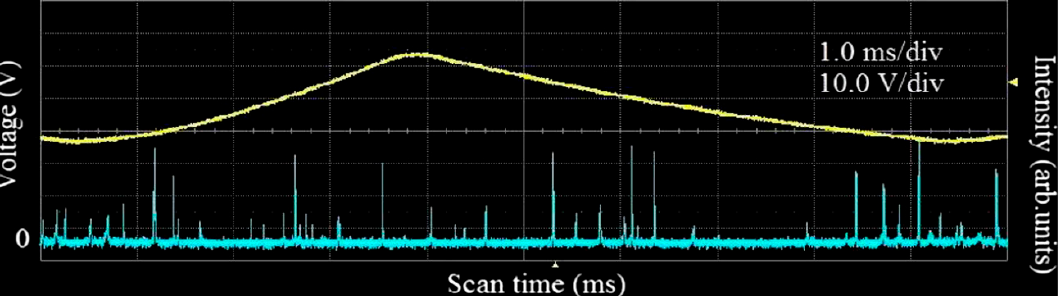
Figure 4. Output mode of the free ‐ running Ho:SSO laser.